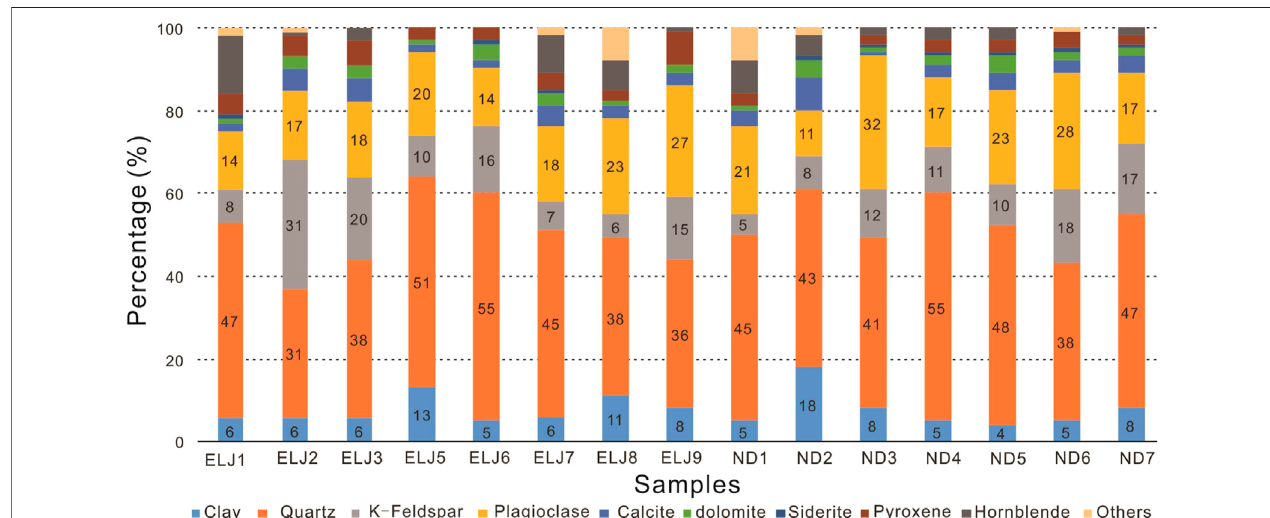
FIGURE 4 | Mineral contents of beach (ND) and beach bar (ELJ) sand sediments from Qinghai Lake.